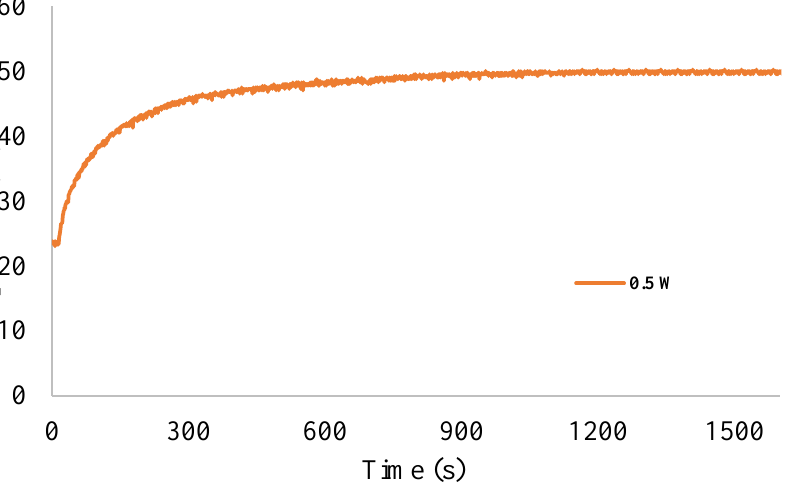
Figure 7. Temperature distribution for the heat sink at 0.5 W.